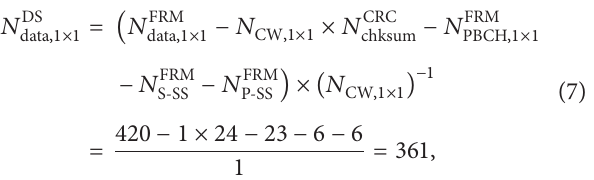
Figure 2: Downlink resource grid [18]. Table 1: Physical resource block parameters